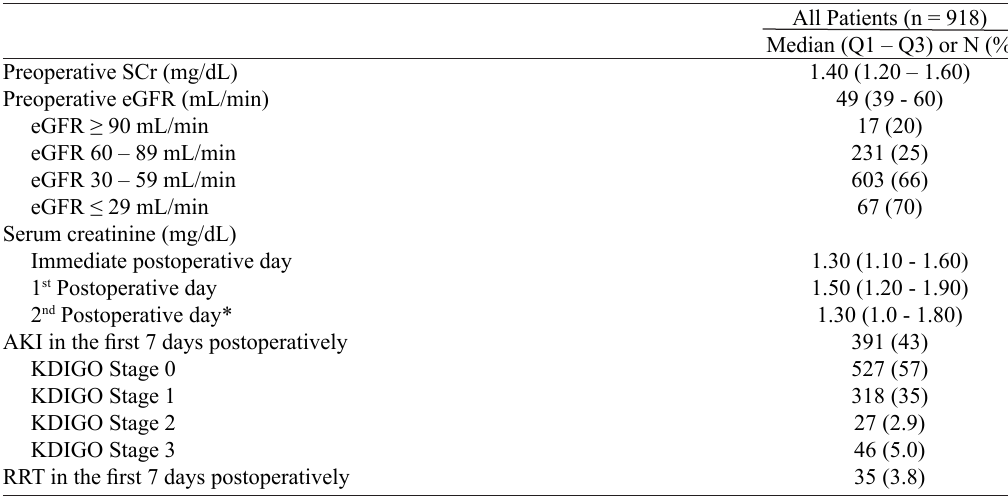
Table 3. Renal function of patients who underwent cardiac